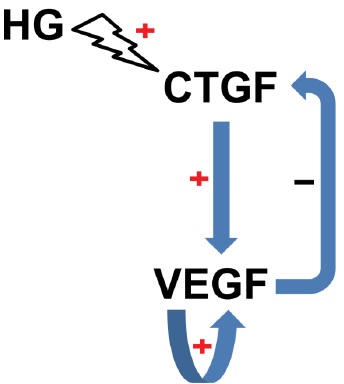
Figure 9. The proposed model for the regulatory network between CTGF and VEGF in the retina of STZ-induced diabetic rats. High glucose up-regulates CTGF, which in turn induces VEGF up-regulation. The increased VEGF transcript or VEGF-mediated signaling has a positive-feedback effect on its own expression and a negative-feedback effect on CTGF